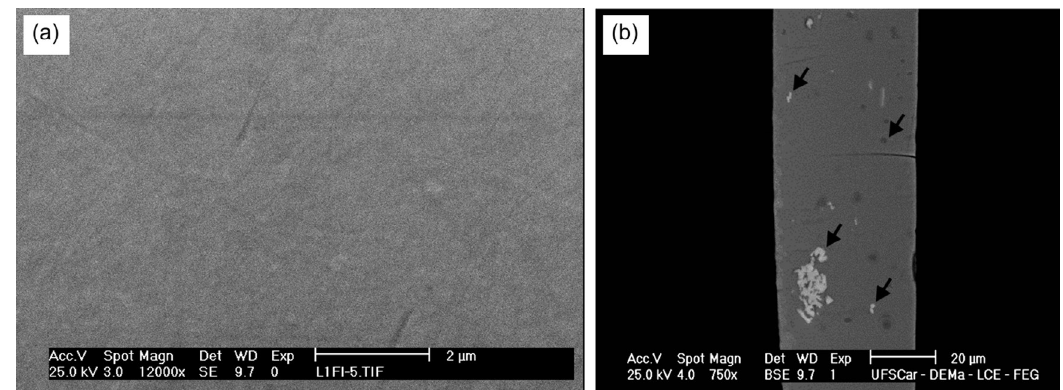
Cr Nb B and (b) Fe 58 10 8 24